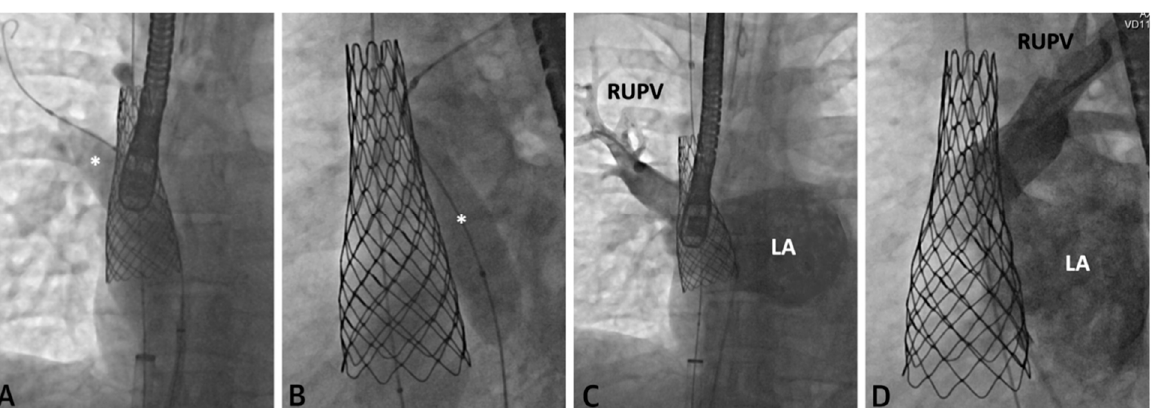
Figure 3. Series of fluoroscopy images depicting balloon test occlusion prior to covered stent place- ment. The patient was deemed to be an unsuitable candidate for covered stent placement as both RUPVs demonstrated an obstructive pattern returning to the LA ( A , B ). Venous return from the RMPV ( C ) was normal. A catheter is seen at the asterisk (*). Revised from ref [4].